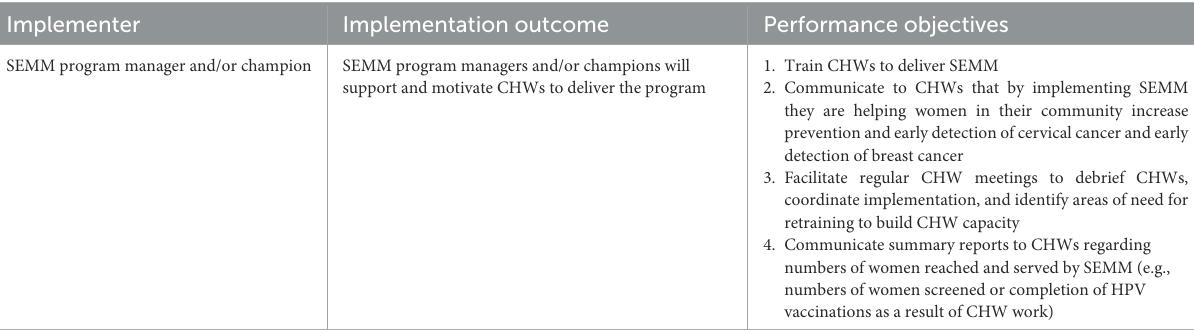
TABLE 3.2 Implementation outcomes and performance objectives: program manager/champion level